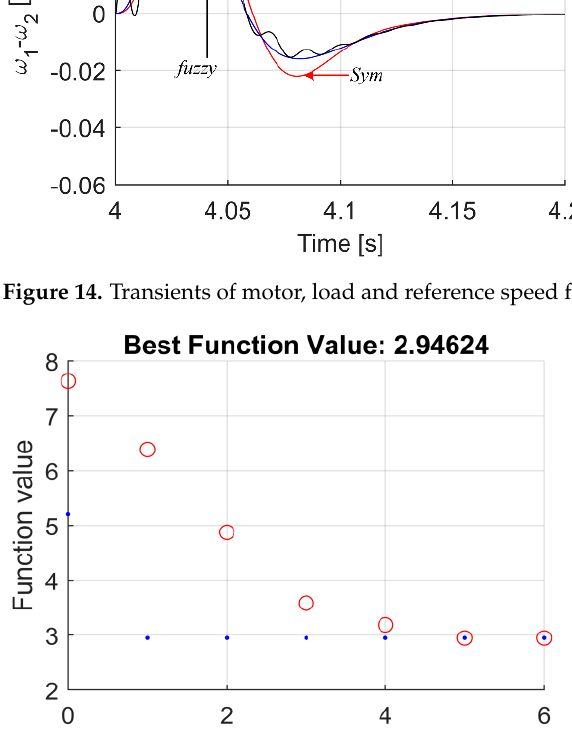
Figure 15. Adaptation process for the controller with type I functions.